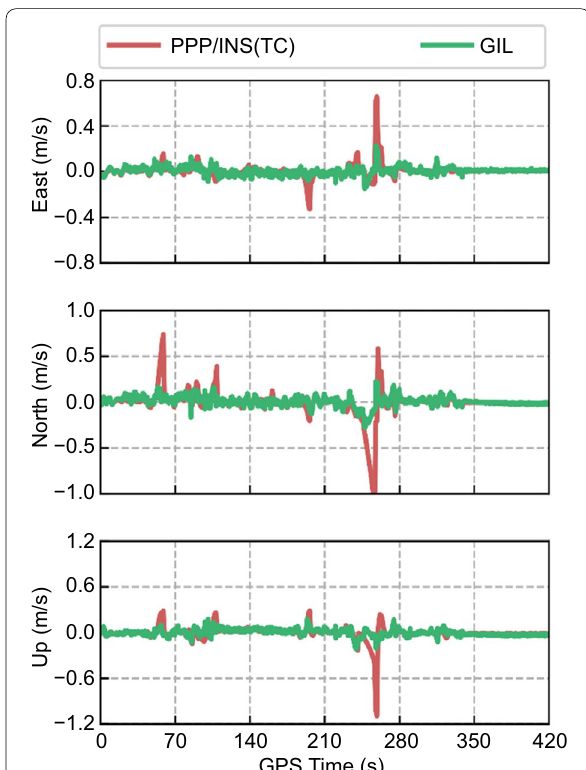
Fig. 10 Attitude offsets of multi-GNSS PPP/INS and GIL methods in GNSS partly-blocked experiment